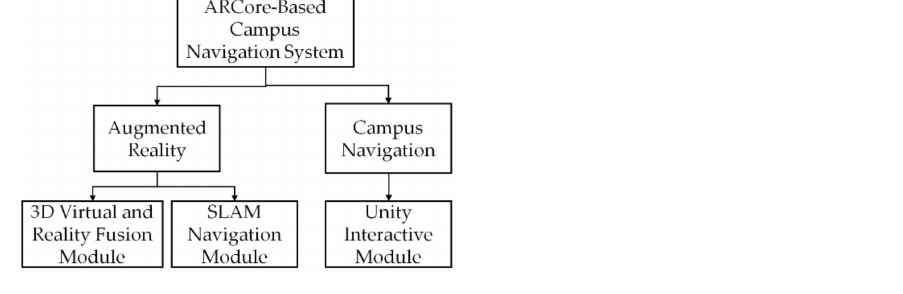
Figure 6. The design of the campus navigation system module based on augmented